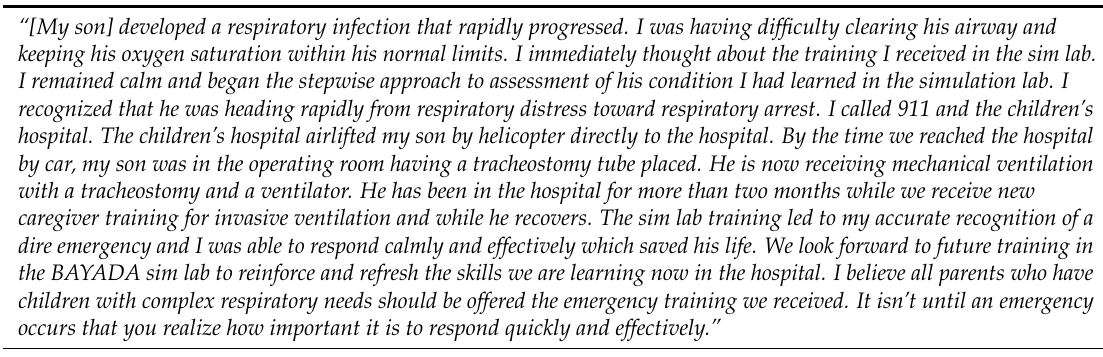
Table 4. Family caregiver responses at